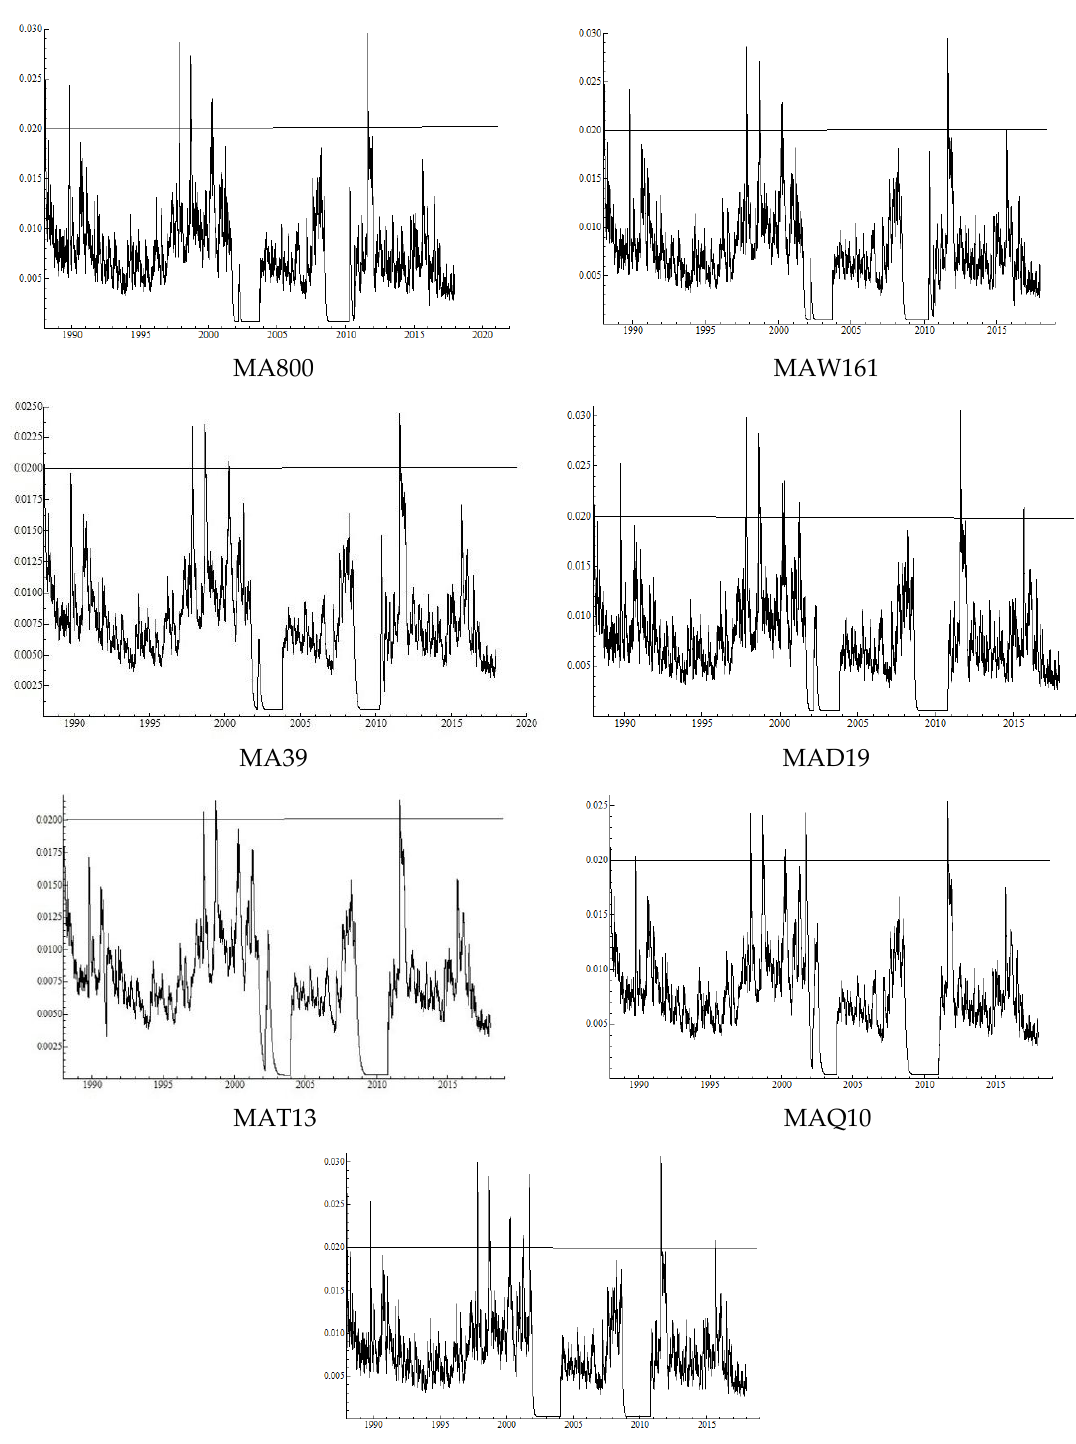
Figure 4. Realized volatilities in 800 trading days rolling window are used. The straight line is the 2% realized volatility bound.